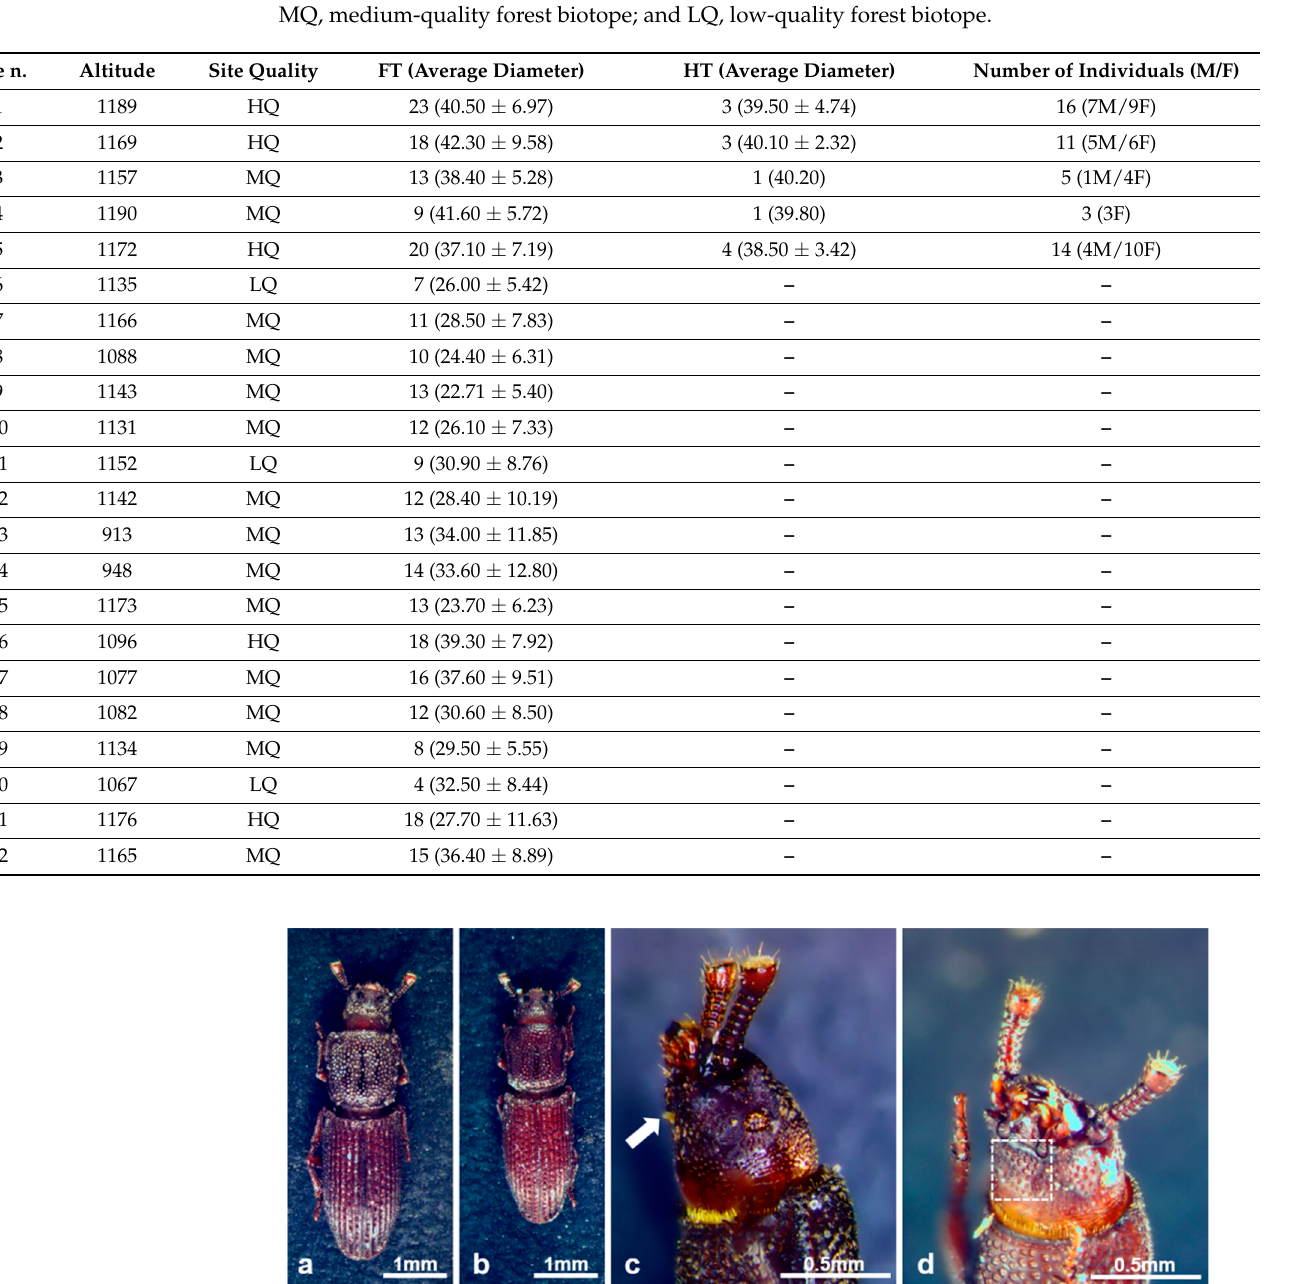
Figure 4. Morphology of adults of P. italicus. ( a ) Male, dorsal view in toto . ( b ) Female, dorsal view in toto . ( c ) Lateral view of the head of the male, showing tufts (arrow) in the outlined structure of the mentum. ( d ) Latero-ventral view of the head of the female, hairless in the outlined structure of the mentum (dashed square).